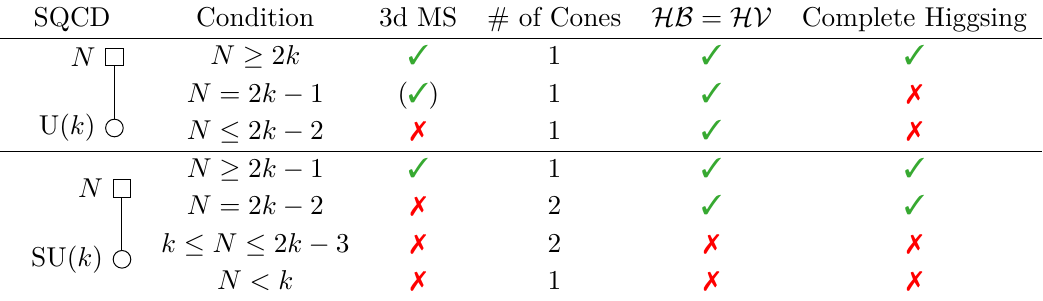
Table 8 . Summary of some properties of SQCD theories with unitary or special unitary gauge group. The unitary case is discussed e.g. in [18], and appendix B. The special unitary case is taken from [10]. The 3d mirror of U ( k ) with 2 k − 1 fundamental hypers consists of its magnetic quiver plus a free hyper, hence the ( 3 ) in the table. HB denotes the (possibly non-reduced) Higgs branch, while HV denotes the Higgs